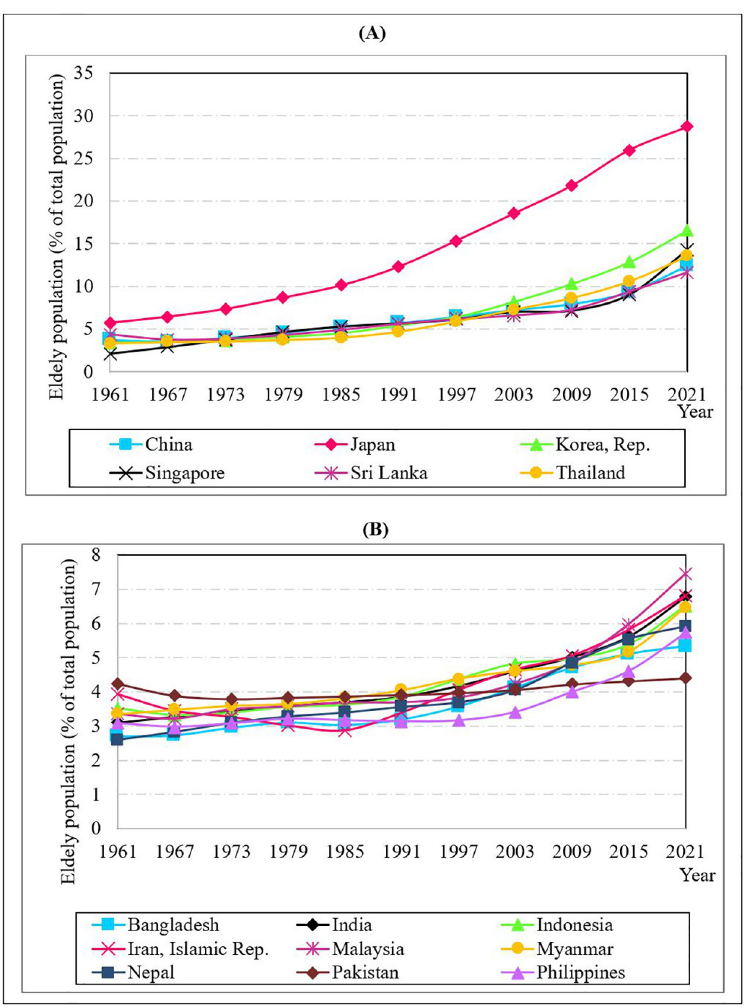
Fig 2. Population aged 65 and older (as a percentage of the total population): A comparison. Source: WDI [51].